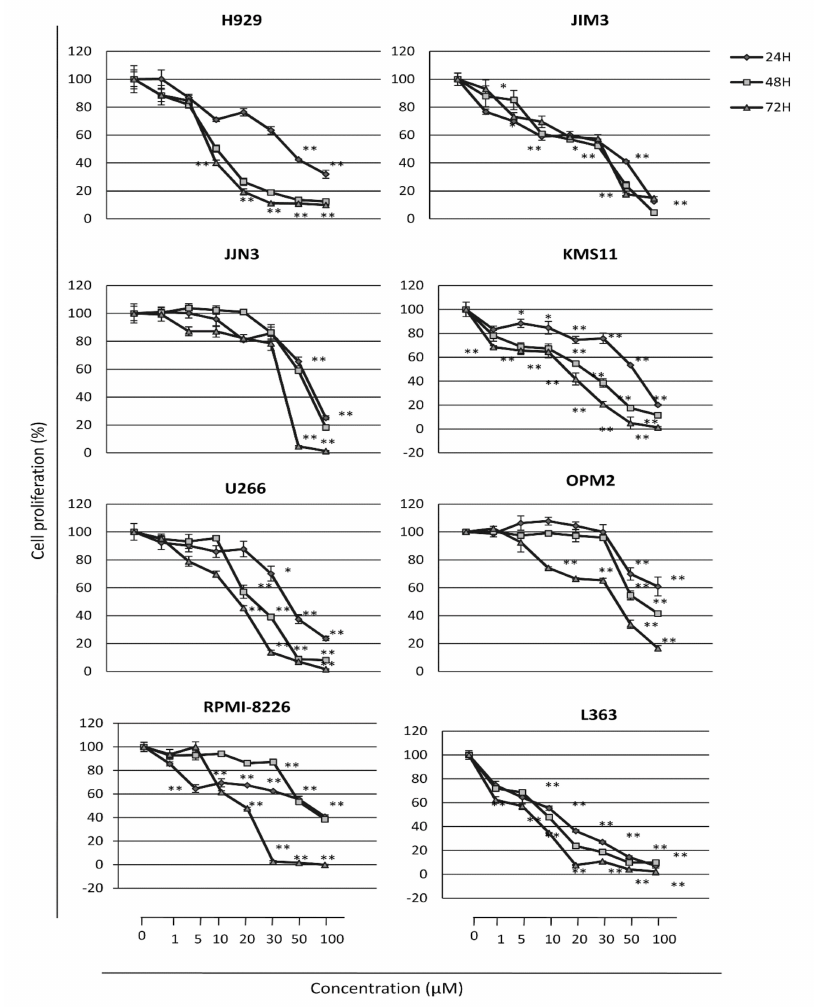
Figure 2. Cell survival of MM cell lines exposed to increasing doses of GSK2606414 for 24, 48 and 72 h, as determined by the Water Soluble Tetrazolium Salt 1 (WST-1) assay. Means ± SDs from three replicates are shown. *, p < 0.05; **, p <